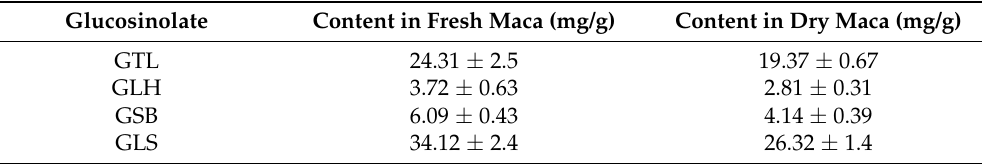
Table 1. The content of benzyl glucosinolate (GTL), m -methoxybenzyl glucosinolate (GLH), p -hydroxybenzyl glucosinolate (GSB), and glucosinolates (GLS) in fresh Maca and dried